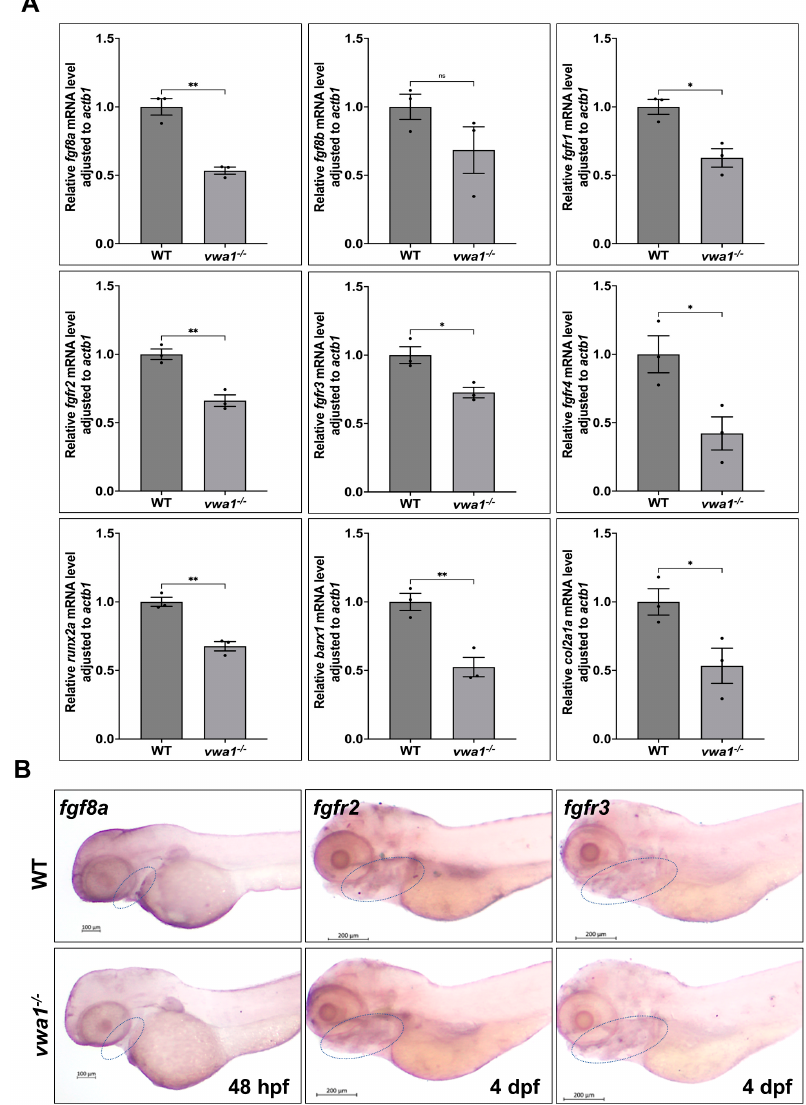
Figure 6. vwa1 regulates FGF signaling in the pharyngeal region. ( A ) RT-qPCR analysis of the mRNA levels of fgf8a , fgf8b , fgfr1 , fgfr2 , fgfr3 , fgfr4 , runx2a , barx1 , and col2a1a in vwa1 − / − zebrafish, showing that all of these FGF signaling pathway components except for fgf8b were decreased in vwa1 mutants. Relative transcription levels were calculated as fold change using the 2 − ∆∆ Ct method. ( B ) WISH staining of fgf8a , fgfr2 , and fgfr3 in vwa1 mutant embryos and WT controls showed that fgf8a , fgfr2 , and fgfr3 expression were all reduced in mutant embryos. The mandibular region is marked with dotted blue circles. Figure S2 Apoptosis did not significantly increase in vwa1 − / − mutants at 30 and 48 hpf. ( A , B ) TUNEL assay (red fluorescence) at 30 hpf demonstrated similar amount of apoptosis cells in the cranial region and dorsal tissues of wildtype controls (WT) and mutants. ( C , D ) TUNEL assay (red fluorescence) at 48 hpf showed similar level of apoptosis in WT and mutants. * p < 0.05; ** p <